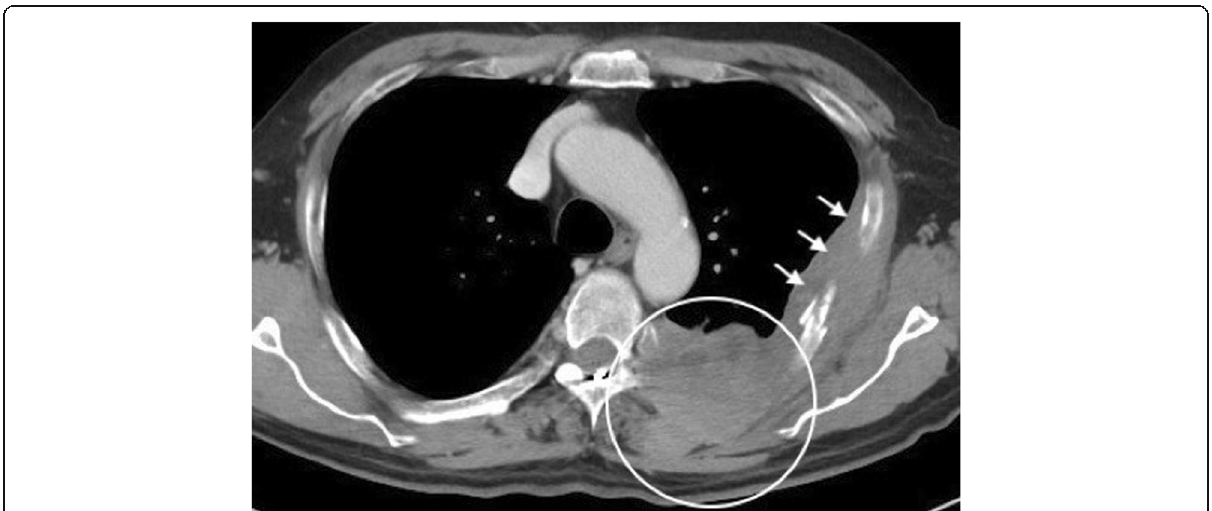
Fig. 2 Axial slice of a CT scan showing a heterogeneous mass infiltrating the posterior thoracic tissue (in the white circle), and pleural thickening (white